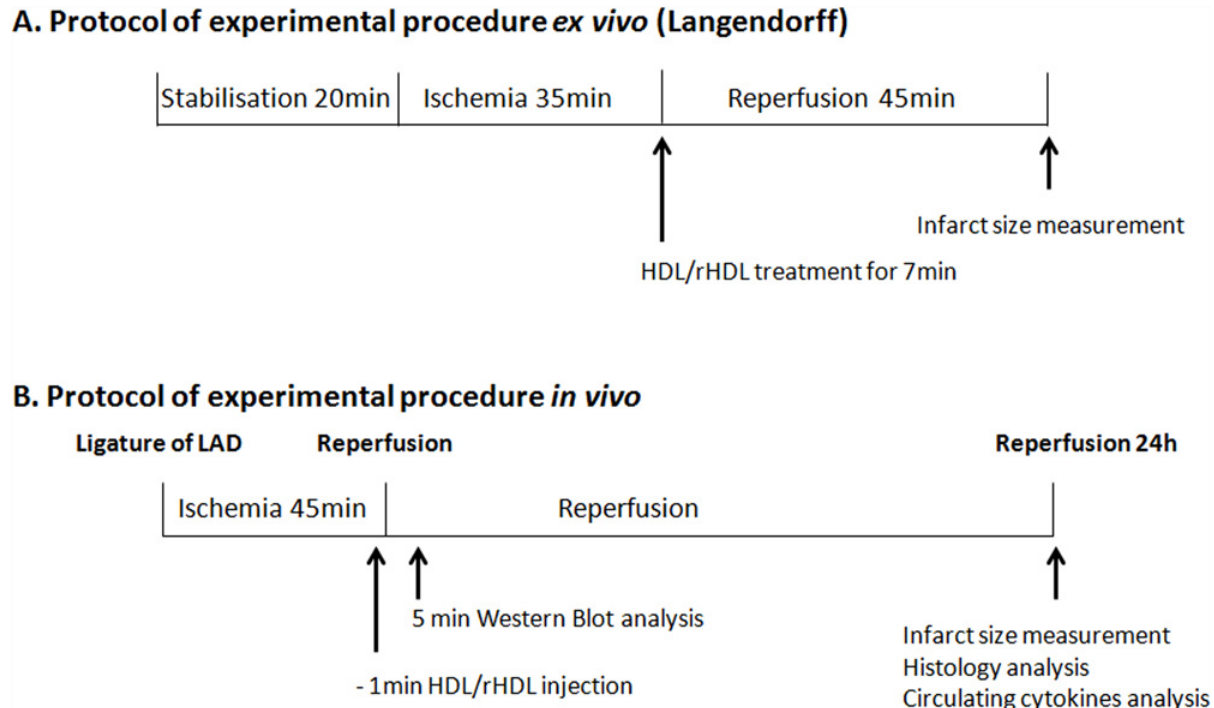
Fig 1. Experimental protocols. A. Hearts from mice were submitted to the ischemia reperfusion protocol as follows: 20min of stabilization, 35min of no-flow global ischemia and 45min of reperfusion. After reperfusion, infarct size was determined. Native HDL or rHDL were added for the first 7min of reperfusion. B. Mice were subjected to LAD occlusion for 45min and hearts were reperfused for different time periods: 5min for Western blot experiments and 24h for infarct size measurement and histological analysis. Serum from mice reperfused for 24h was collected for analysis of circulating cytokines. Native HDL or rHDL were injected one min before